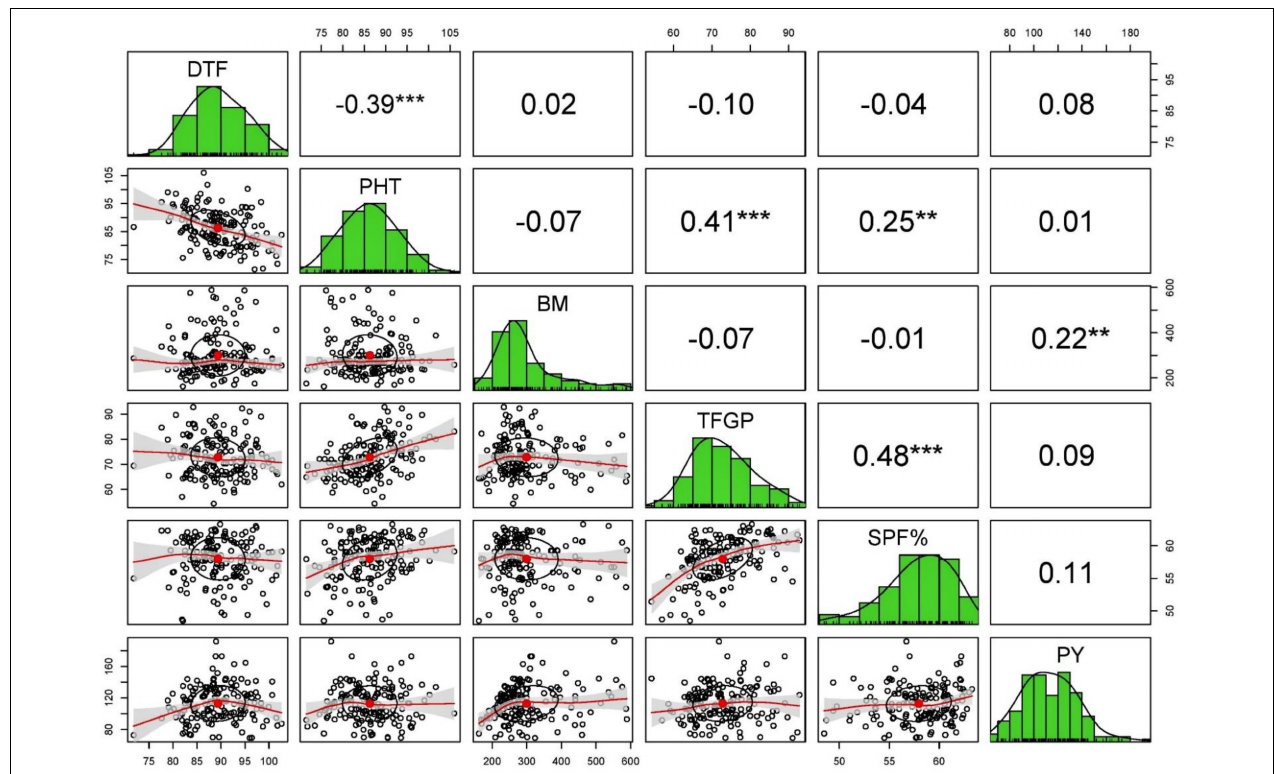
FIGURE 4 | The scatterplot matrix shown here has histograms of the variables in the diagonal, and correlation coefficients in the upper part of the matrix under stress condition of 2016